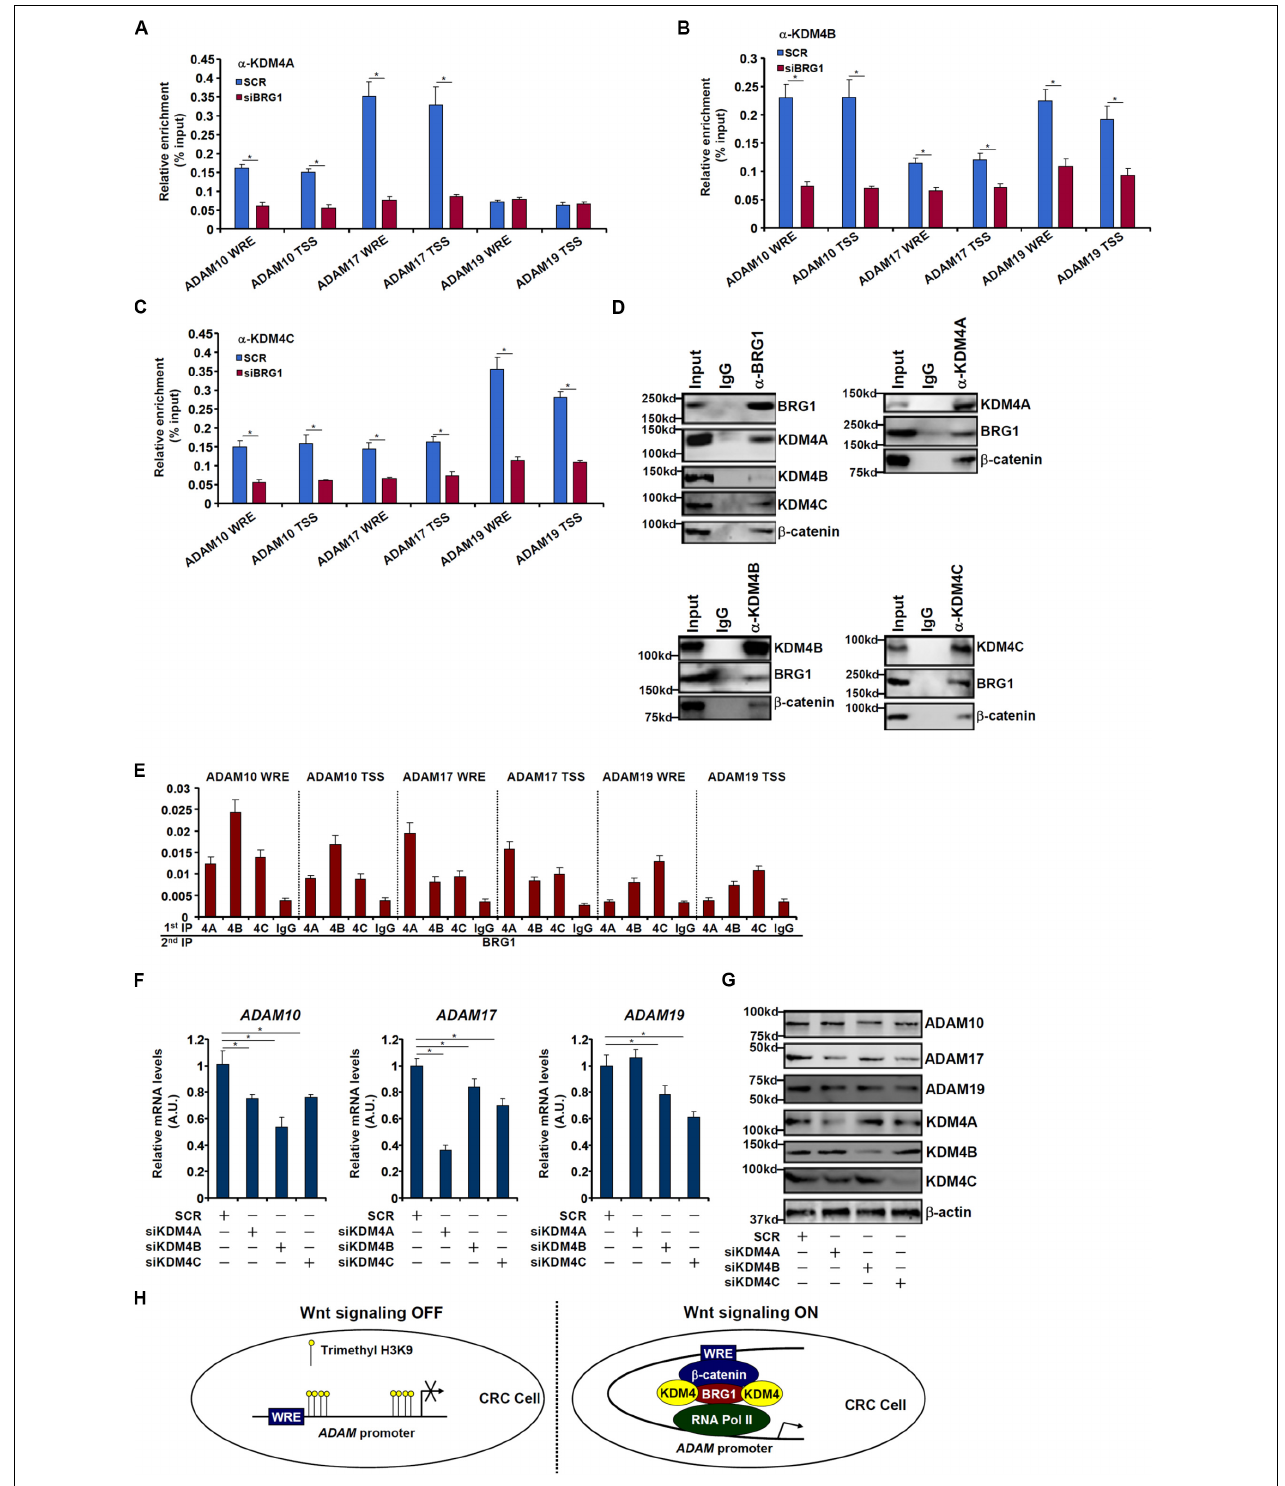
FIGURE 6 | BRG1 recruits KDM4 to activate ADAM transcription. (A–C) SW480 cells were transfected with siRNA targeting BRG1 or scrambled siRNA (SCR). ChIP assay was performed with indicated antibodies. (D) Nuclear lysates were extracted from SW480 cells. Immunoprecipitation was performed with indicated antibodies. (E) Nuclear lysates were extracted from SW480 cells. Re-ChIP assay was performed with indicated antibodies. (F,G) SW480 cells were transfected with siRNA targeting KDM4 or scrambled siRNA (SCR). ADAM expression levels were examined by qPCR and Western. (H) A schematic model. Data represent averages of three independent experiments, and error bars represent SEM ( p < 0.05, two-tailed Student t test).